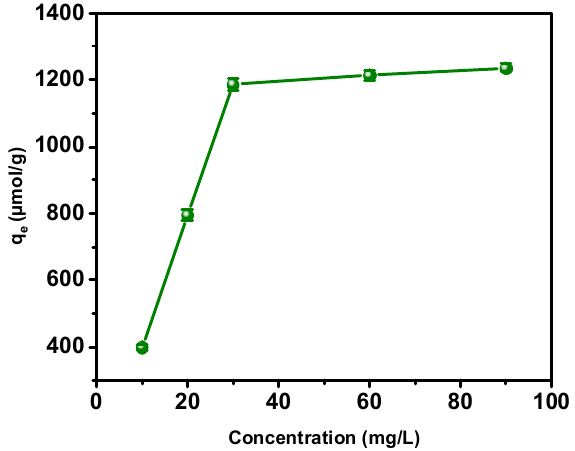
Figure 10. The adsorption capacity of Pb 2+ under different initial concentrations. (Experimental conditions: pH = 6, MnO 2 /Mxene composite films 12 mg, solution volume 100 mL, 25 °C).